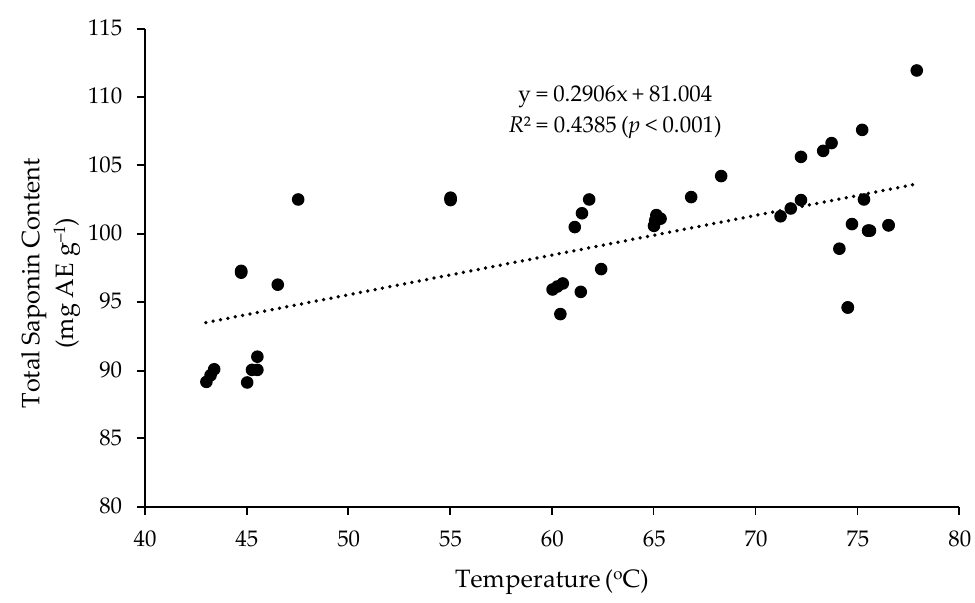
Figure 5. Correlation between the TSC and the temperature of the extract at the end of various MAE treatments. The black dots: TSC at different temperature of the extracts.